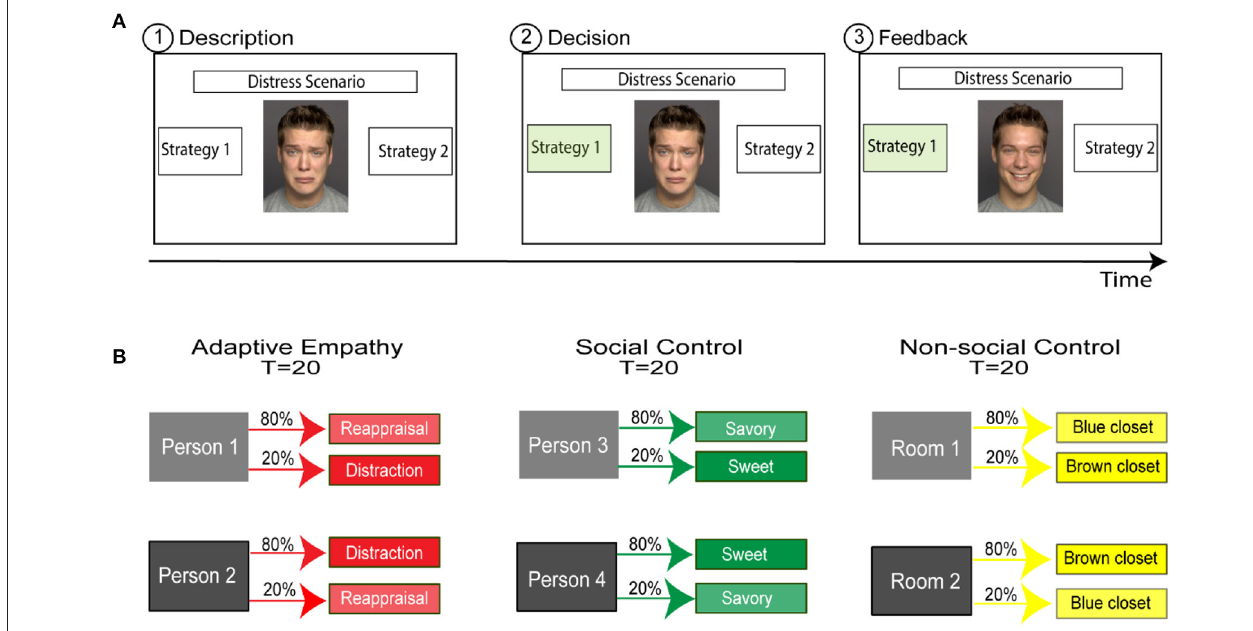
FIGURE 1 | Experimental Design. (A) A sample trial in the adaptive empathy condition. Participants had to choose between two options and learn which one was more likely to lead to a desirable outcome. Each trial consisted of three stages: (1) Participants were shown a picture of a person with a sad facial expression, together with a textual description of the current cause of the person’s distress. Textual descriptions of two empathic responses corresponding to two different emotion regulation strategies were also provided. (2) Participants chose one of two responses. (3) Feedback was provided regarding the effect of the chosen strategy, as indicated by the person’s face changing to a happy expression or remaining sad. (B) Overall experimental design of the adaptive empathy task. The task included three experimental learning conditions carried out by all participants. In each condition, participants learned about one person/room. The order of the blocks and the preferred strategy learned in each block were randomized across